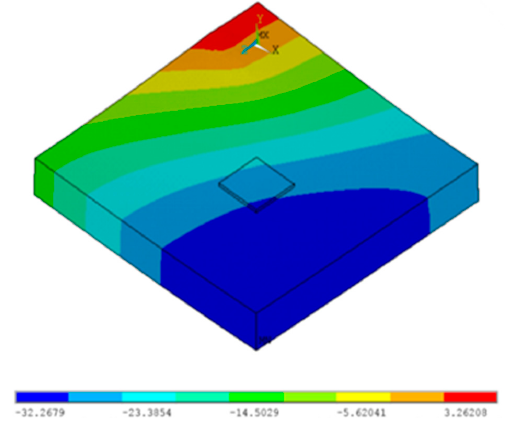
Figure 14. Deformation shape of BN slab.